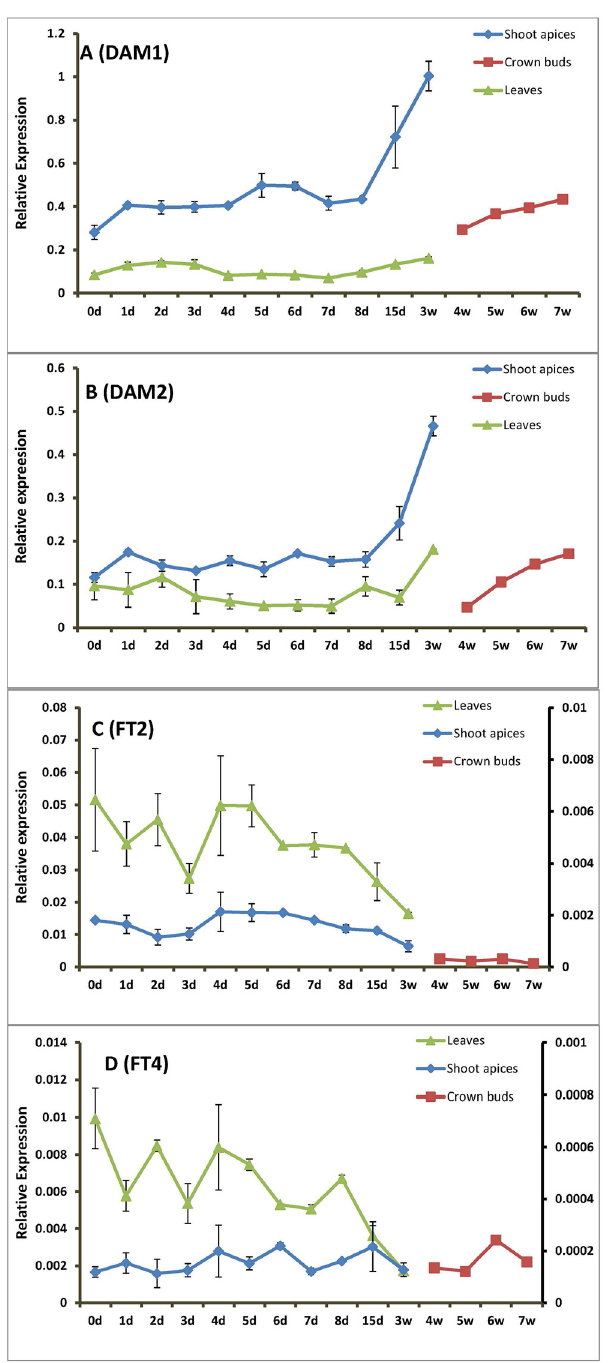
Fig 4. The average expression patterns of leafy spurge DAM and FT . Transcript levels for (A) DAM1 , (B) DAM2 , (C) FT2 , and (D) FT4 are shown during 7 weeks of endodormancy-inducing conditions. The plants were treated with long-photoperiod (16 hr) but cold nights, mornings and evenings (11°C for 16 hr) for endodormancy induction. The expression patterns of the four genes were examined at different duration of endodormancy induction in leaves and shoot apices/crown buds (in shoot apices from 0d to 21d, in crown buds from 4 weeks to 7 weeks). X-axis represents the length of dormancy induction (day (d), week (w)), and the right Y axis, when present, represents the expression of the FT genes in shoot apices/crown buds. Error bars show range from two replicates.